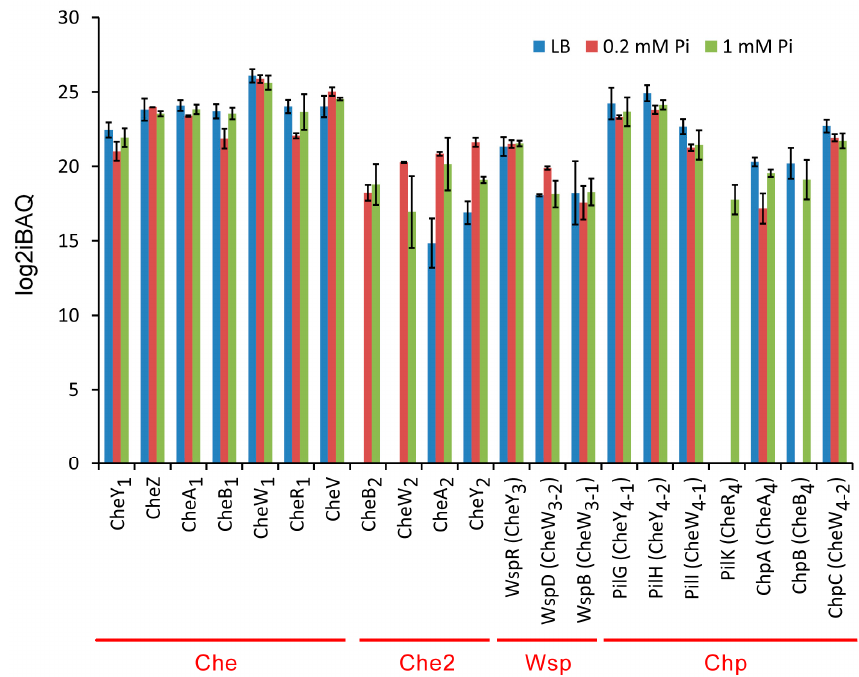
Figure 6. Absolute amounts of the chemosensory signaling proteins of the 4 chemosensory pathways of P. aeruginosa PAO1 grown in LB medium or minimal medium with 0.2 mM and 1 mM Pi. The corresponding pathways are indicated in red. Error bars represent standard deviations from the mean intensity Based Absolute Quantification (iBAQ) index.